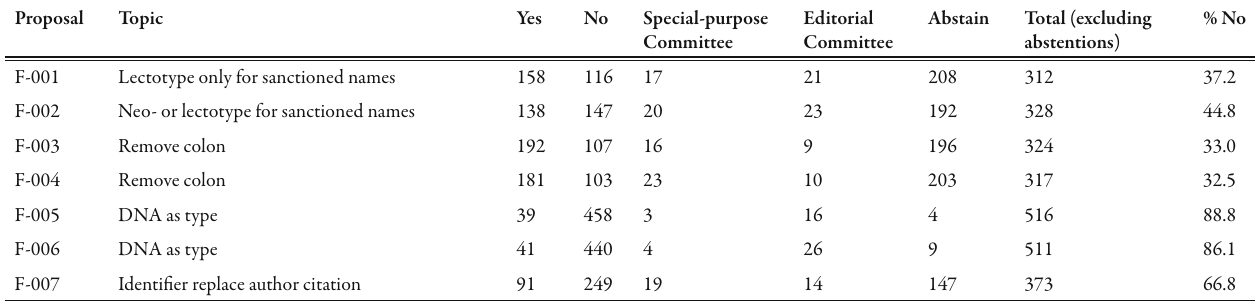
Table 1. Valid votes for each option in the IMC11 Guiding Vote. %No is calculated as proportion of Total votes cast (excluding abstentions). Proposal